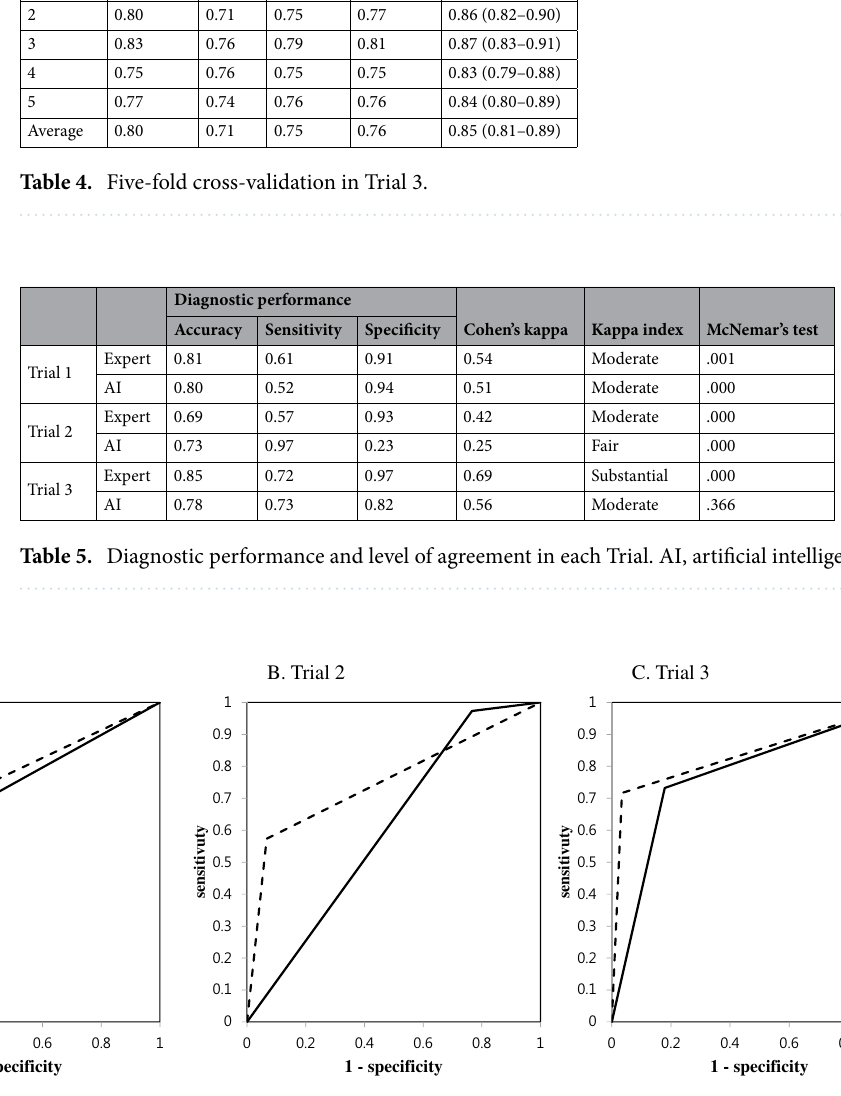
Figure 1. Comparison of the sensitivities and specificities in Trials 1, 2, and